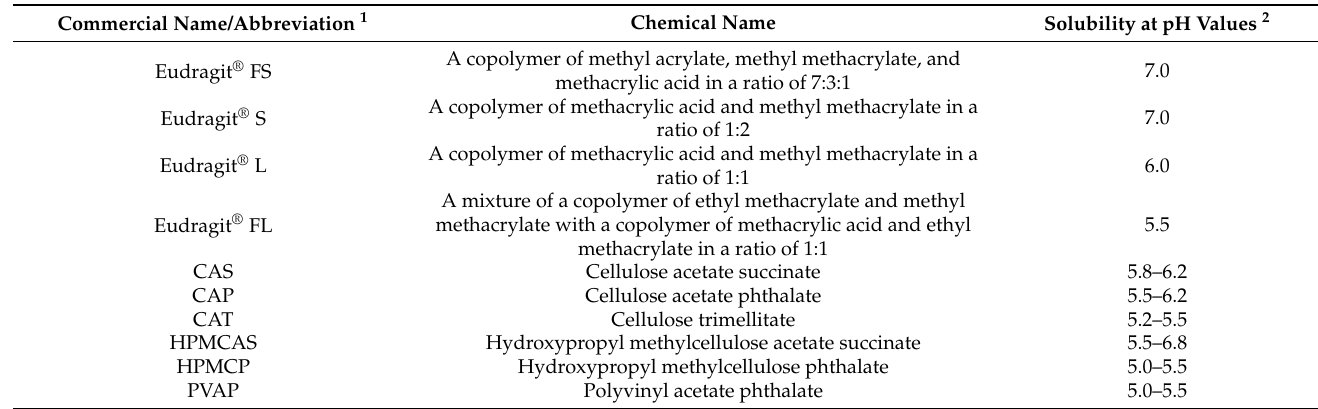
Table 2. Overview of the most common pH-dependent enteric polymers